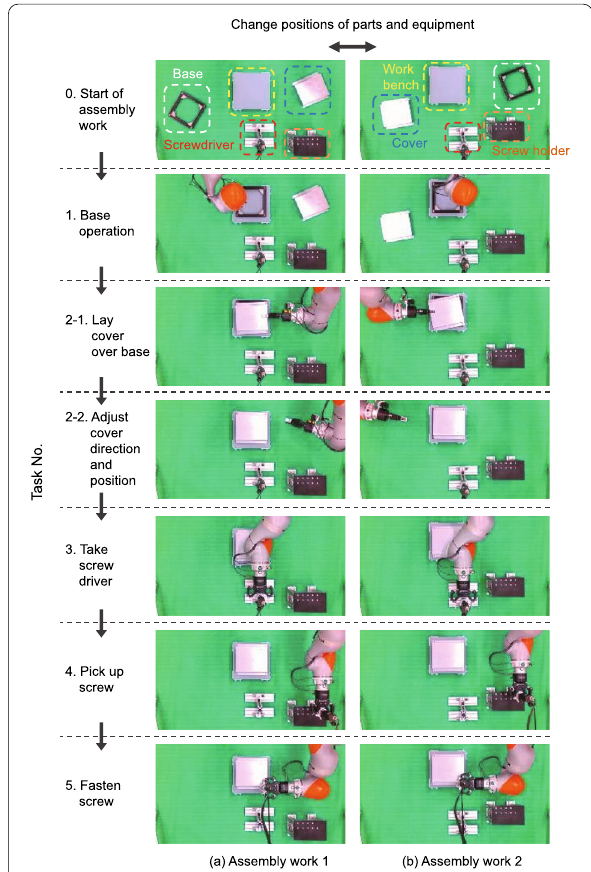
Fig. 11 Task execution result: parts and tools are in different positions